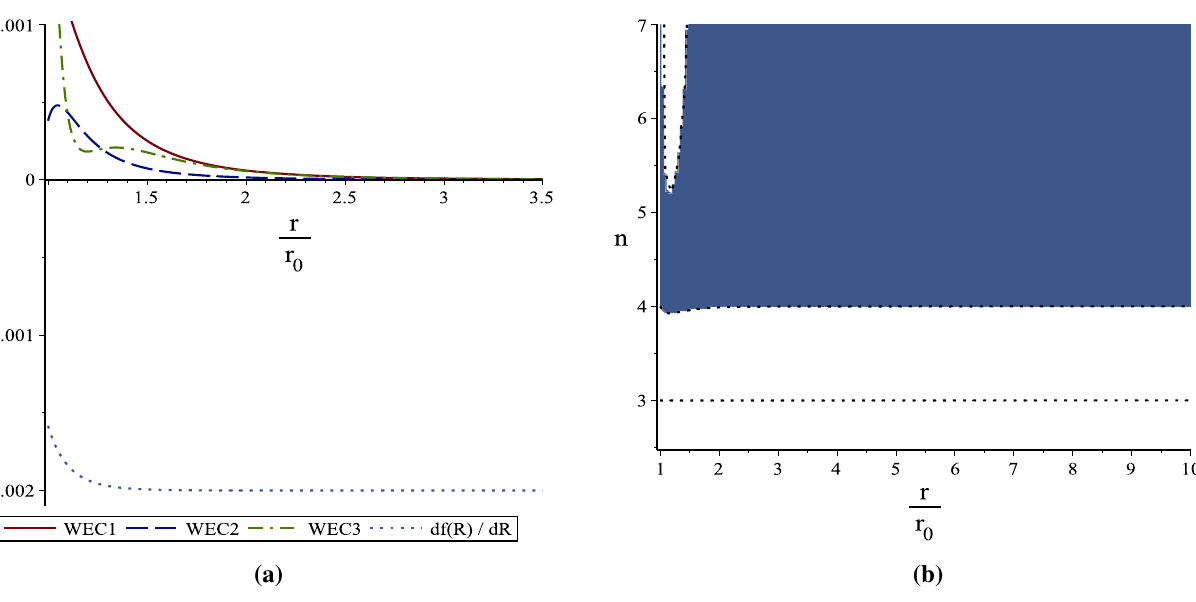
Fig. 2 F = df ( R )/ dR and weak energy condition requiements for a wormhole solution of the Tsujikawa model with n = 5 are depicted in a . It is obvious that F < 0, so the condition of wormhole nonexistence is violated. It is also clear that WEC is respected at the throat r 0 and